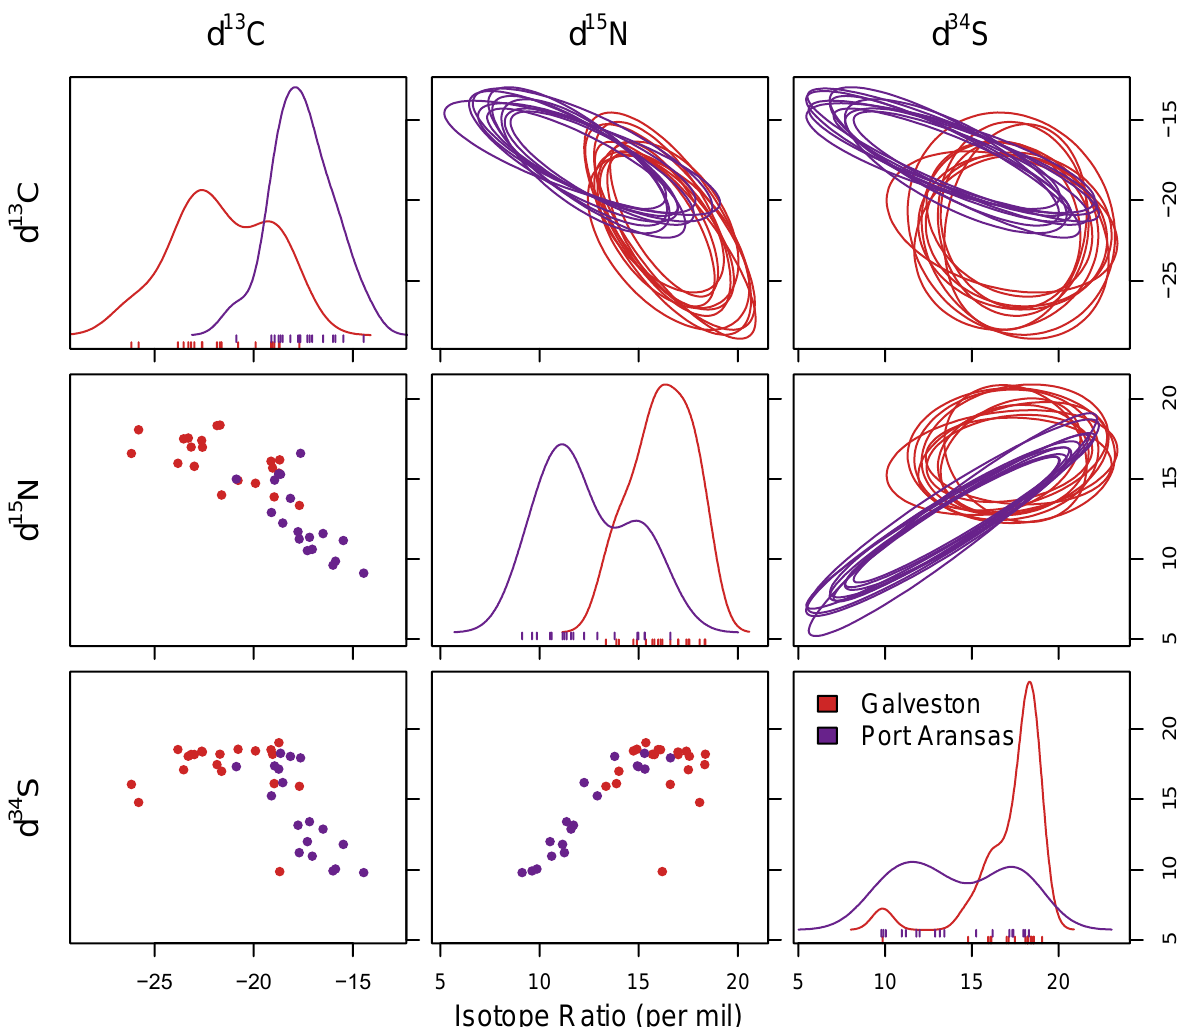
Figure 3. Niche separation of sheepshead using stable isotope values (δ 13 C, δ 15 N, and δ 34 S) measured in liver samples. Six comparisons were made across each of the three stable isotope values (δ 13 C vs. δ 15 N, δ 34 S vs. δ 15 N, and δ 13 C vs. δ 15 N) as well as single isotope values. The bottom left shows the depictions of the raw data as a simple biplot and diagonally are the distributions for sheepshead from both locations for single isotope values. The upper right-hand corner shows 10 random draws of niche region that were estimated using each combination generated using Monte Carlo